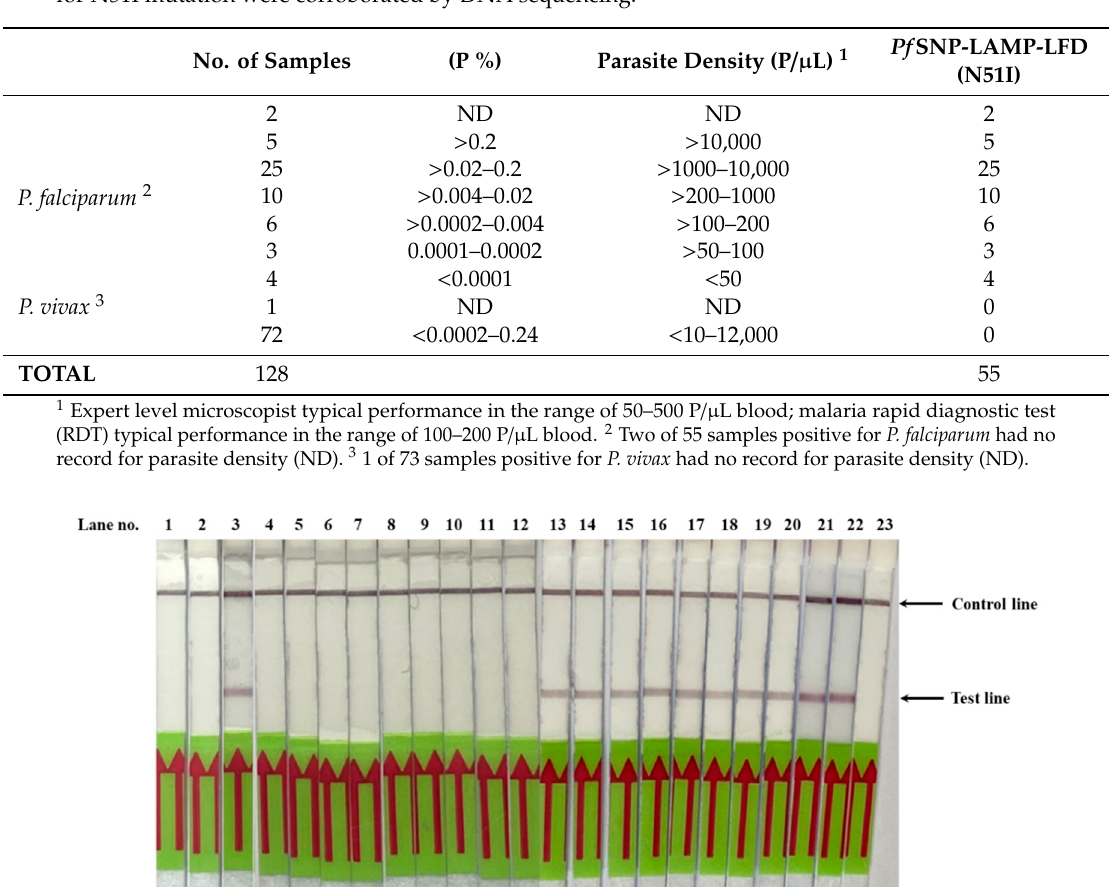
Table 1. Summary of results from Pf SNP-LAMP-LFD detection of SNP for N51I mutation in 128 clinical malaria samples from Thailand categorized by malaria species and parasite density. Samples with SNP for N51I mutation were corroborated by DNA sequencing.